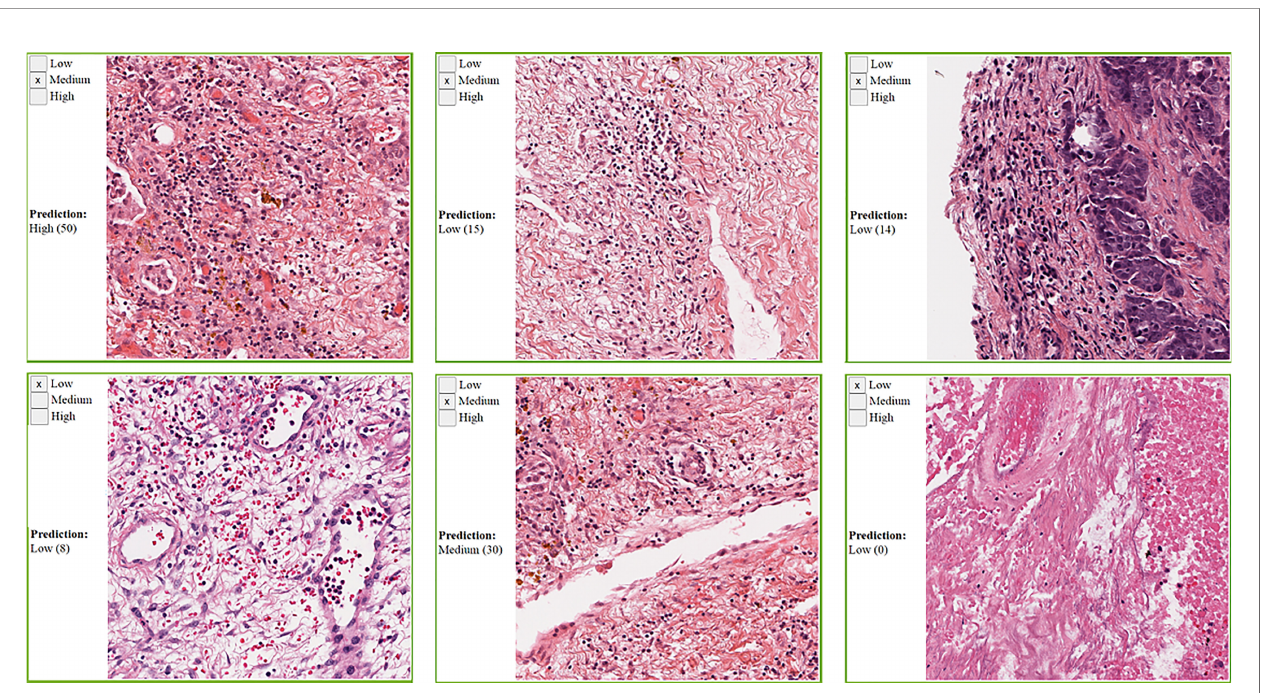
Frontiers in Oncology |